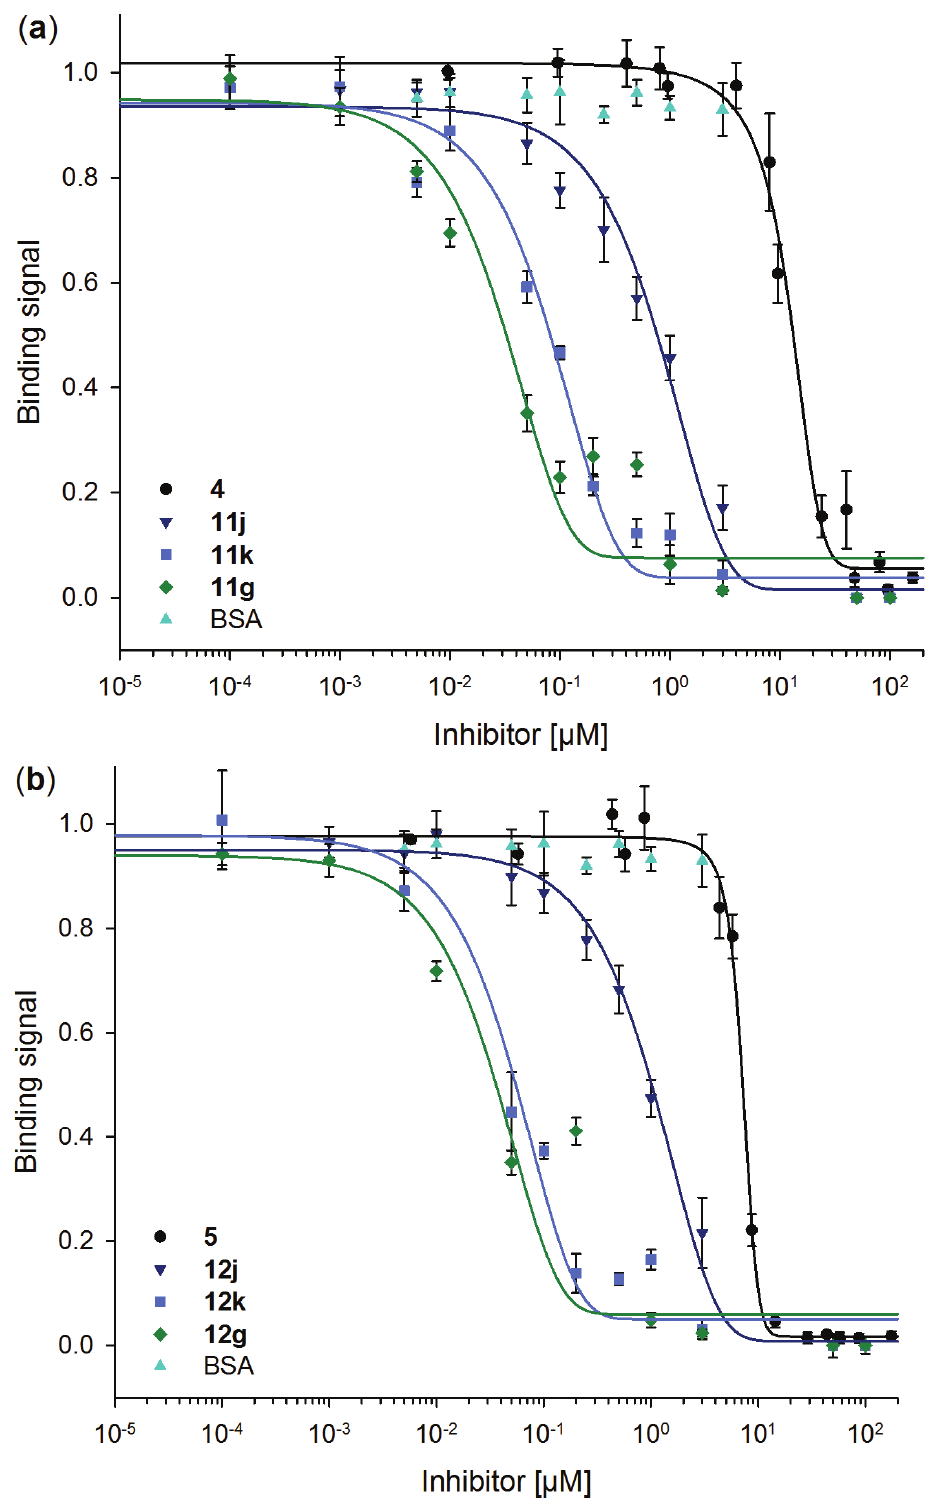
Figure 6. Competitive inhibition of galectin-3 binding to ASF with free tetrasaccharides and neo-glycoproteins. Residual binding of 5 μM galectin-3 to ASF in the presence of variable concentrations of ( a ) LacNAc-LacNAc ( 4 ) and LacNAc-LacNAc conjugated BSA ( 11j , 11k and 11g ) and ( b ) LacDiNAc-LacNAc ( 5 ) and LacDiNAc-LacNAc conjugated BSA ( 12j , 12k and 12g ) is shown. Unmodified BSA has no influence on the galectin-3 binding. Inhibition curves were fitted using Sigma Plot